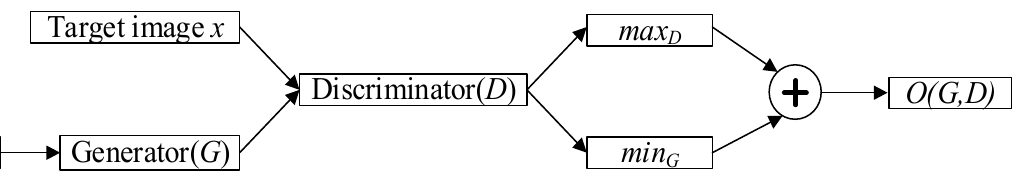
Figure 1. Structure of a generative adversarial network